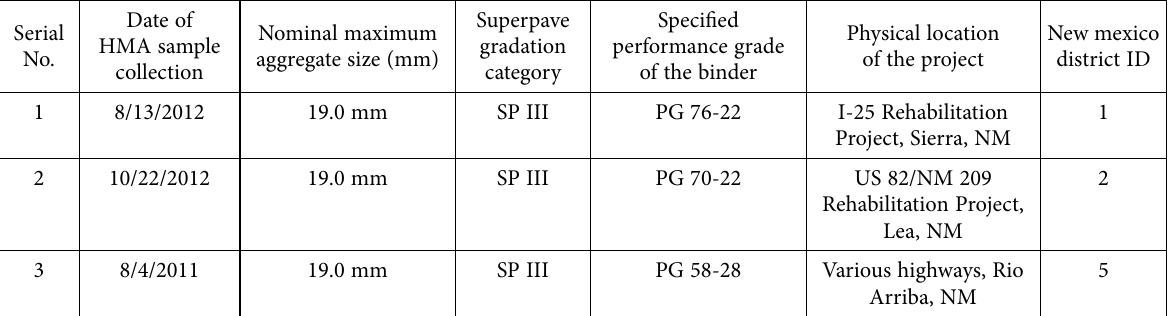
Table 3. Data summary of collected HMA